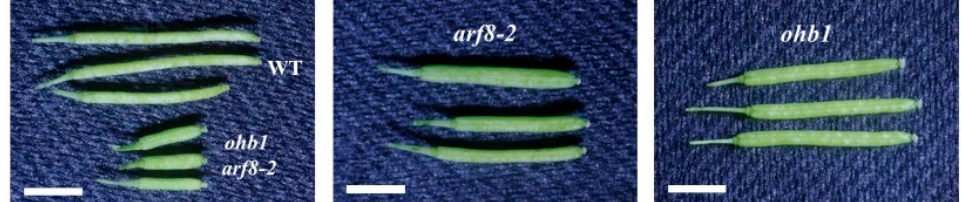
Figure 4. Fruits produced by the mutant lines related to ohb1 and arf8 . Bars represent 3